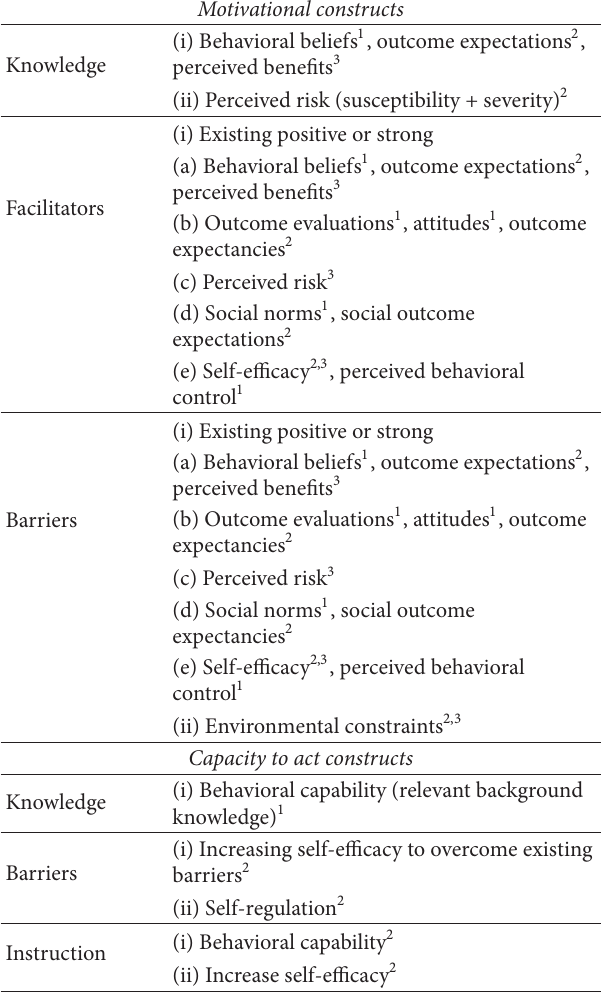
Table 1: Alignment of theoretical constructs with simplified medi- ators in research content